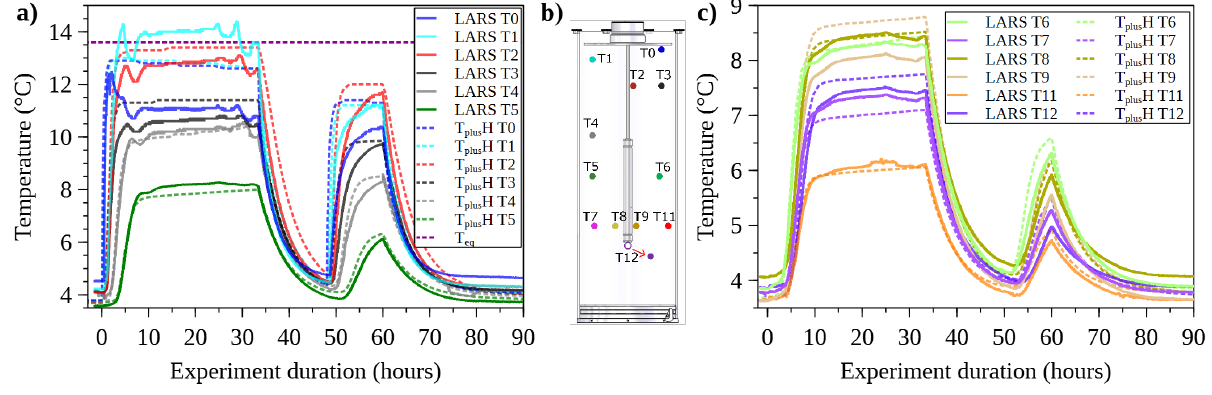
Figure 5. Overview of temperature evolution during 90 h of hydrate formation: comparison of observed temperatures at the RTDs T0–T5 ( a ) together with T6–T9, T11, and T12, ( c ) with the T plus H simulation results (dashed) obtained by revising the RTD locations in the numerical model; the equilibrium line T eq identifies the CH 4 hydrate stability temperature of 13.6 °C at the given pressure and salinity; ( b ) schematic of the revised RTD locations within LARS (not to scale). LARS T0–T12 data were adapted from the CH 4 hydrate formation experiment conducted by Priegnitz et al.